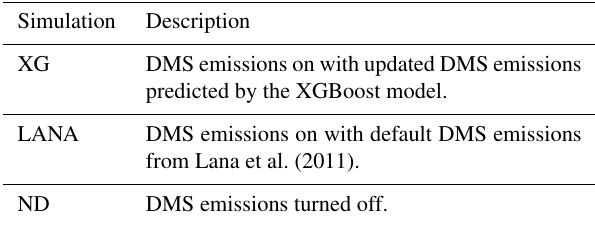
Table 1. Description of the simulation.